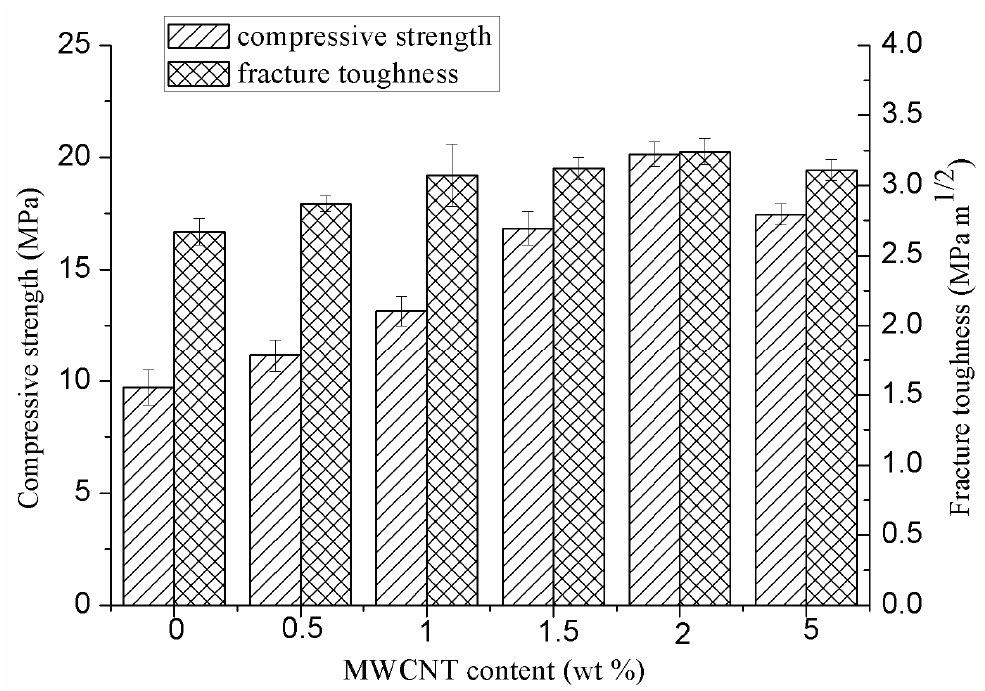
Figure 2. Compressive strength and fracture toughness of the scaffolds with different MWCNTs content.